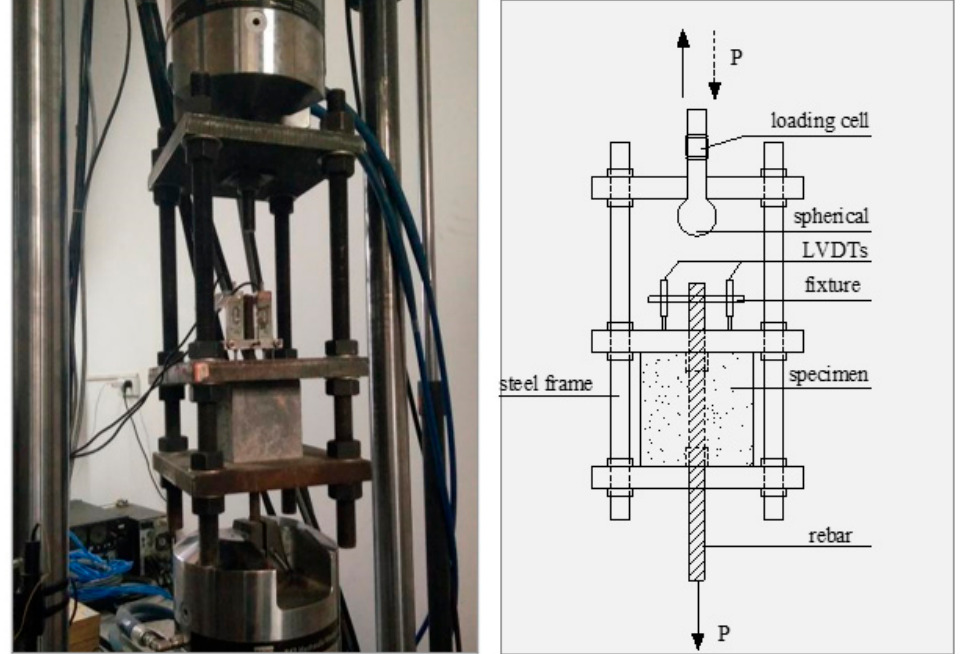
Figure 2. Test setup.